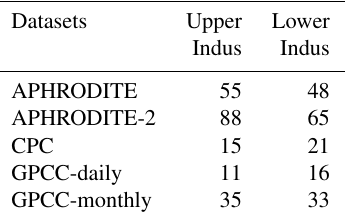
Table 2. Number of stations used on average for the rain-gauge- based datasets (except CRU for which this information was not di- rectly available), per time step, for the two study areas, and over the period